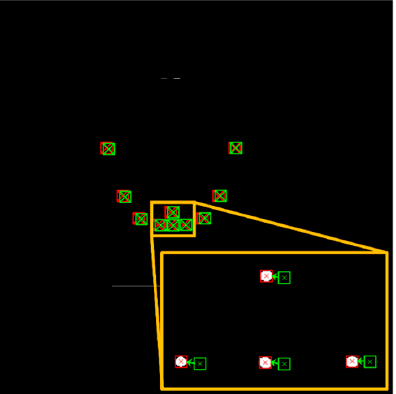
( d ) Figure 6. Image processing pipeline for markers’ detection: ( a ) two subsequent images illuminating the target asynchronously with the two sources at 800 nm and 850 nm are collected; ( b ) a difference intensity image is obtained by subtracting the two acquired images; ( c ) Otsu’s global thresholding is applied to compute the binary mask of the difference image; ( d ) the weighted centroids of the candidate markers (in red) are finally detected from the binary mask after a sorting process to dis- card noise and outliers. 3.1.2. Identification The identification step establishes the 2D–3D correspondences between the candi- date markers found within the image and their real-world counterparts, i.e., their position vector in the TGFF. First, the markers are reprojected on the image plane (direct mapping) based on their known 3D location in target coordinates and the pose initial guess. The reprojected mark- ers are then compared to the detected ones, and matches are found through a Nearest Neighbor (NN) process. To avoid mismatches due to residual false detections, each can- didate is associated to the closest reprojected marker only if their pixel distance is smaller than a safety threshold τ id . This threshold is again computed adaptively based on d ig and considering the minimum real-world distance between two retroreflectors (i.e., 0.2 m)